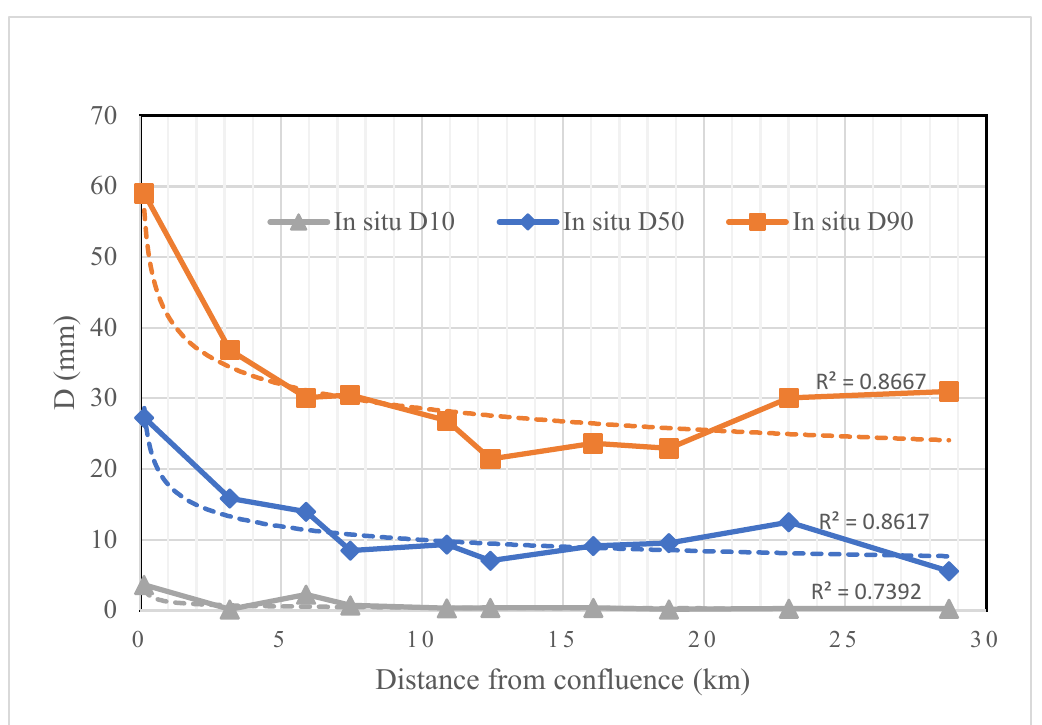
Figure 6. The power relationship of the average values of specific grain sizes (D 10 , D 50 , and D 90 ) along the longitudinal profile of the Baganza River.